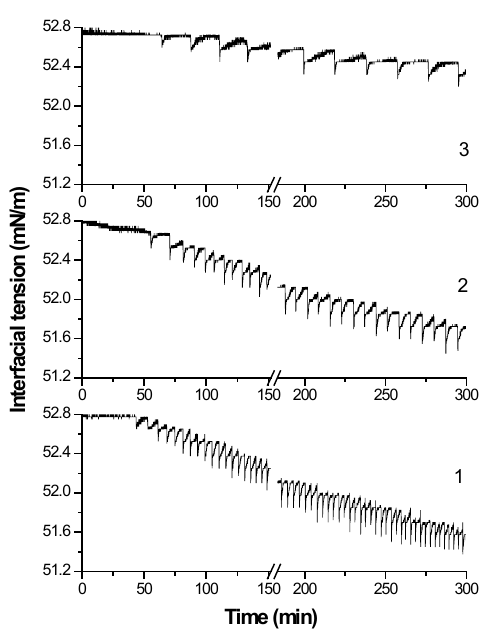
Figure 9: Oscillations in the liquid membrane system without chemical reactions: acceptor phase – pure dodecane, membrane – pure water, donor phase: 1 – pentanol, 2 – hexanol, 3 – heptanol. Reprinted with permission from [42]. Copyright 2006 American Chemical